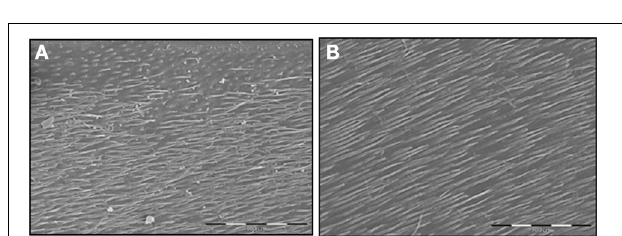
FIGURE 1 | Schematic representation of MMP activity during the dentin carious process. Cariogenic bacteria present in the caries cavity release acids such as lactic acid that reduce the local pH. The resulting acidic environment demineralizes the dentin matrix and induces the activation of host MMPs derived from dentin or saliva (which bathes the caries cavity). Once the local pH is neutralized by salivary buffer systems, activated MMPs degrade the demineralized dentin matrix.